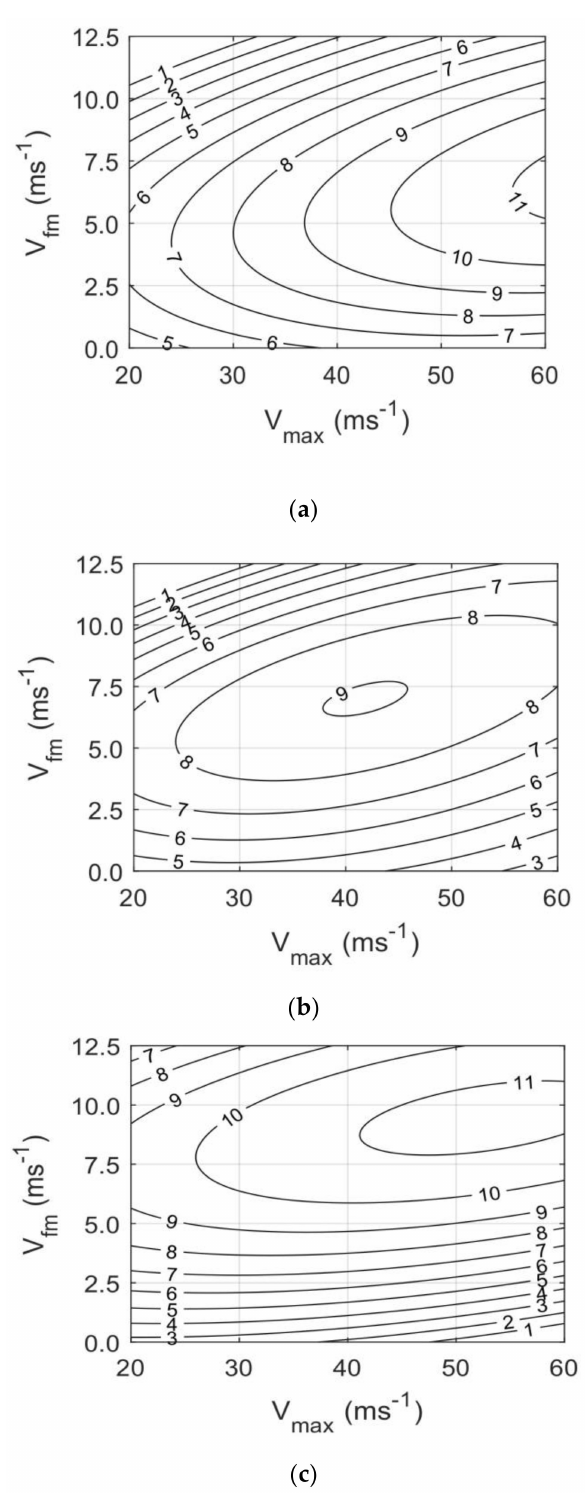
Figure 4. The tropical cyclone effective fetch. Contours are of x / R (cid:48) . The results shown are for ( a ) top—Young [30], ( b ) middle—Young and Burchell [38] and ( c ) bottom—Young and Vinoth [56]. With the equivalent fetch defined, Young [43] used the JONSWAP relationship [46] to determine the maximum significant wave height within the storm, H max s